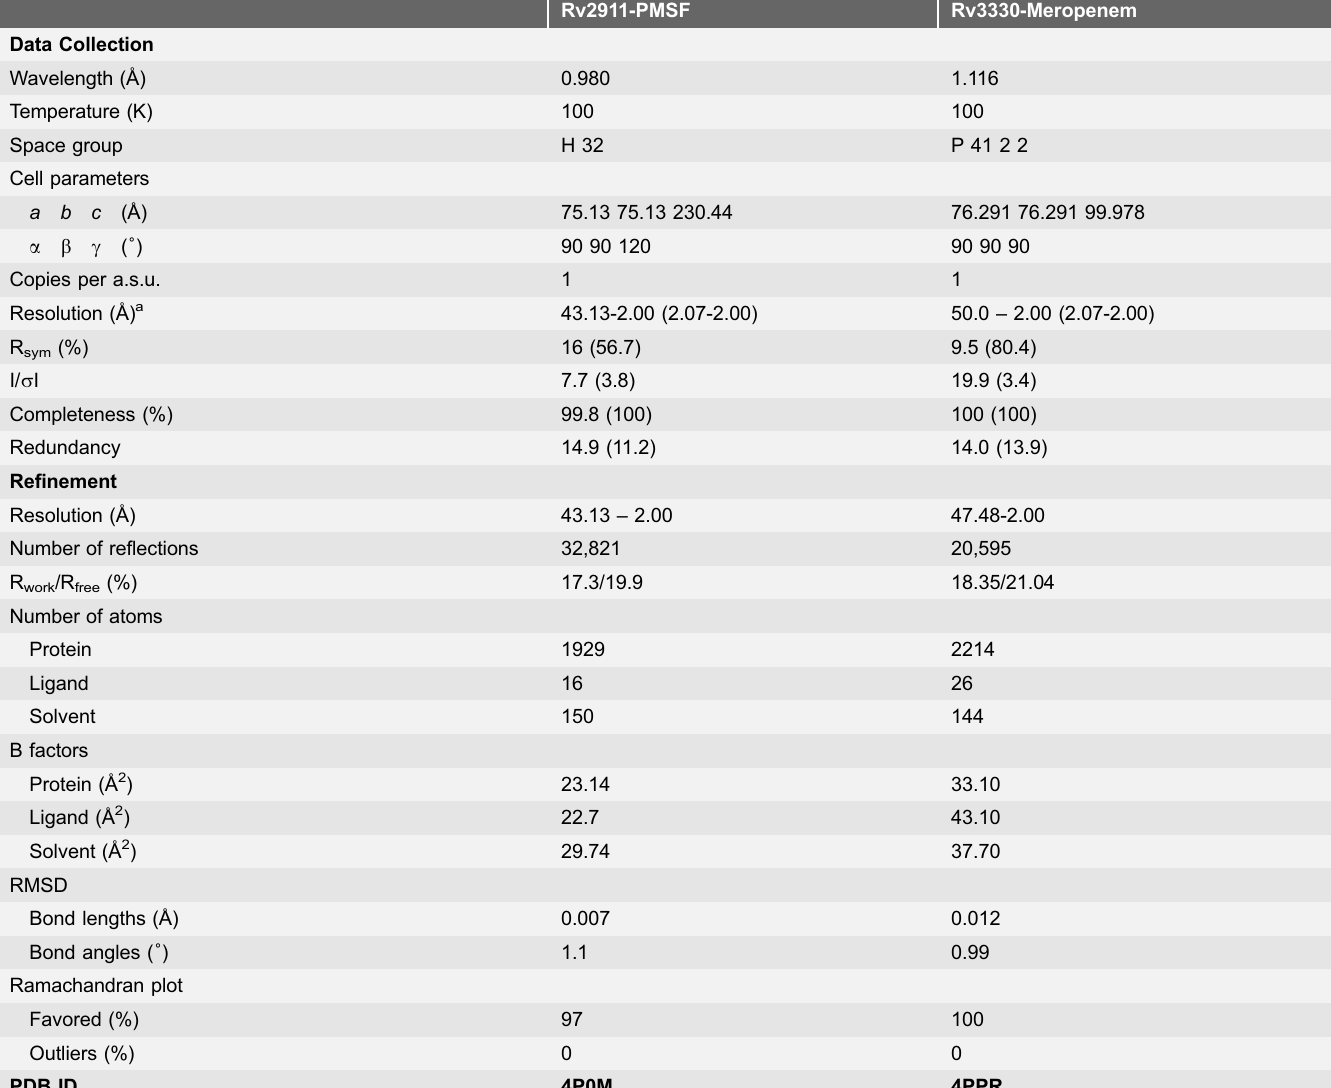
Table 1. Data collection and refinement